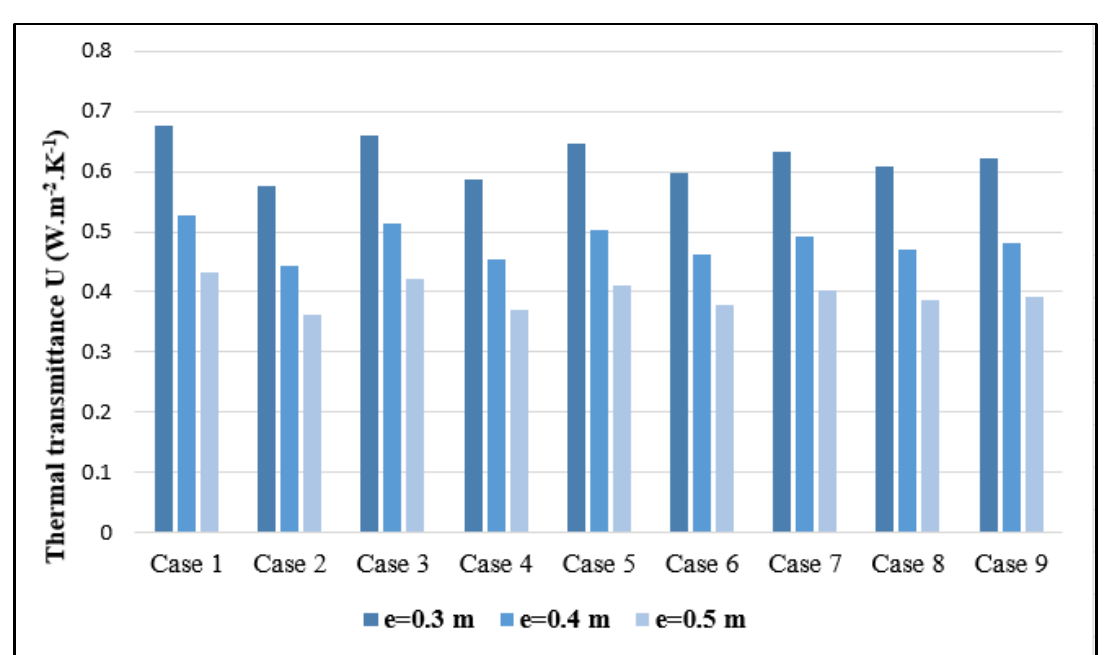
Figure 3. Case studies of thermal transmittance of the multilayer material.